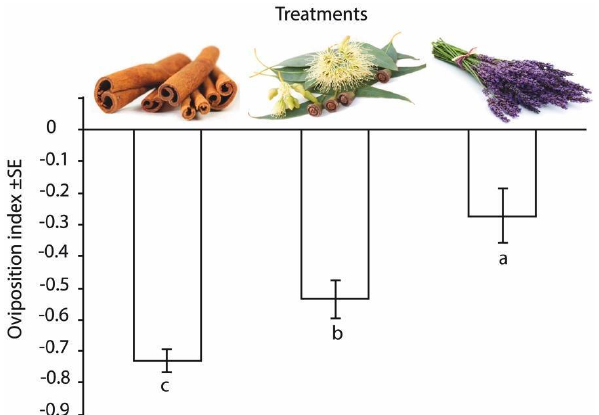
Figure 2. Oviposition indices (Oi) calculated from two-choice oviposition assays where boxwood plants treated with ( a ) lavender ( b ) eucalyptus and ( c ) cinnamon, and essential oil filled vial-wick dispensers were offered against untreated plants as oviposition sites for box tree moths ( Cydalima perspectalis ). Columns differing significantly (ANOVA, Games–Howell post hoc test, p < 0.05) are labelled.